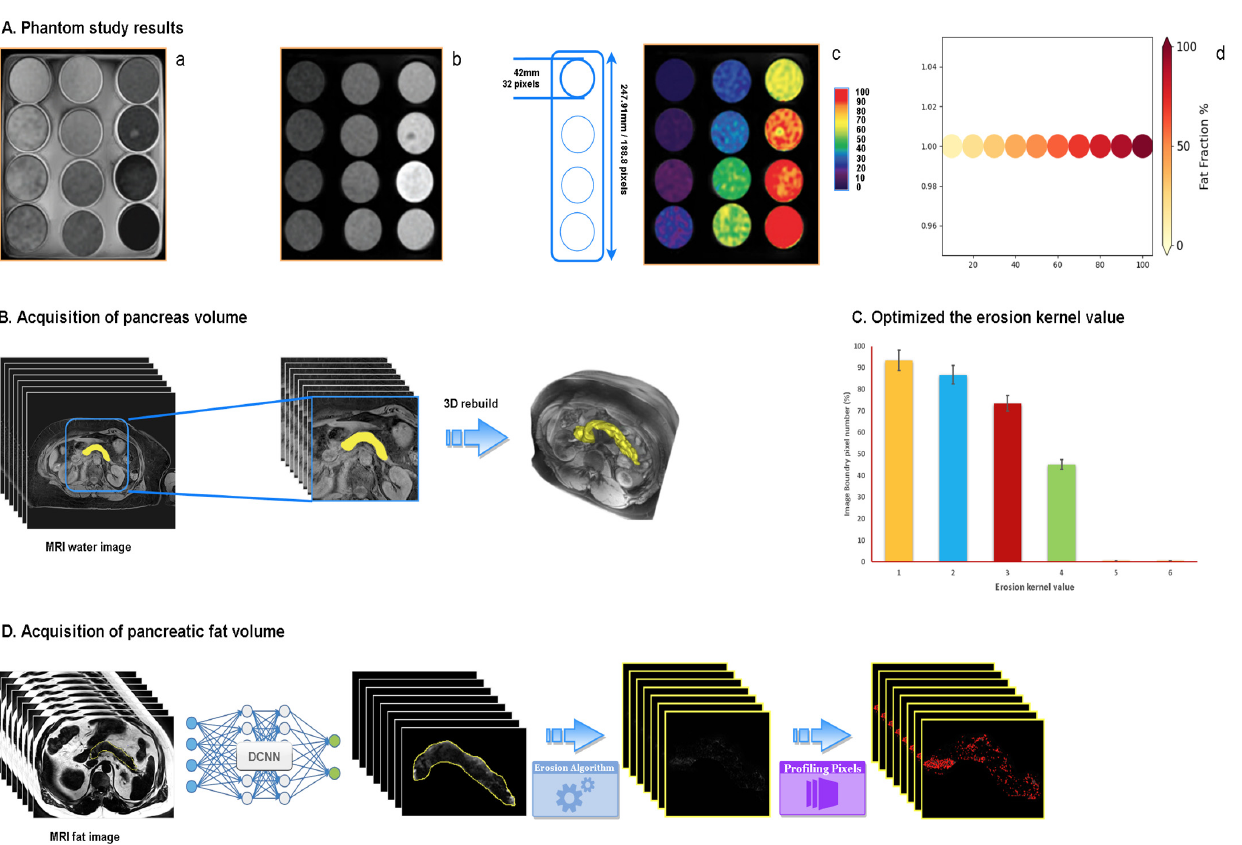
Figure 3. Processing of pancreatic tissue scan and its inner fat volume acquisition. ( A ) Phantom results under the same MRI conditions: ( a ) water phase MRI scan; ( b ) fat phase MRI scan; ( c ) heatmap of fat gradient generated by app in MRS; ( d ) digital converted fat fraction gradient generated by python pillow algorithm for machine learning; ( B ) method of acquisition of pancreas volume and its 3D rebuilt result; ( C ) optimization of erosion kernel value; and ( D ) process of acquisition of pancreatic fat volume from MRI fat image to profiling pixels.